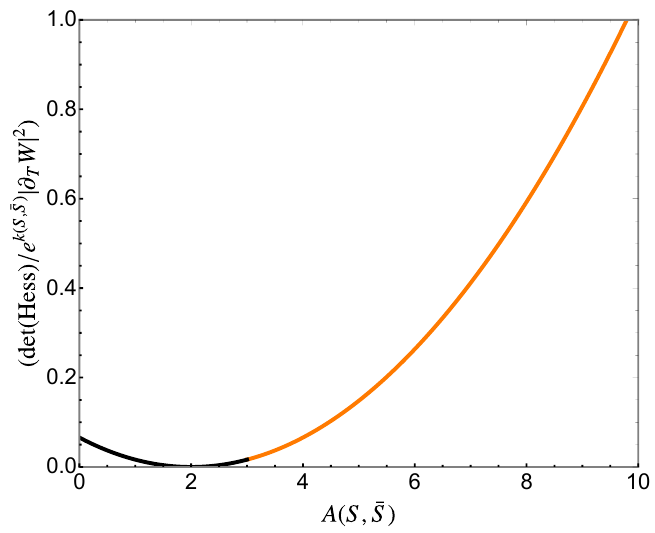
Figure 4 . Rescaled Hessian determinant of the Kähler modulus block at T = ρ . Again the orange segments correspond to dS vacua assuming a stabilized